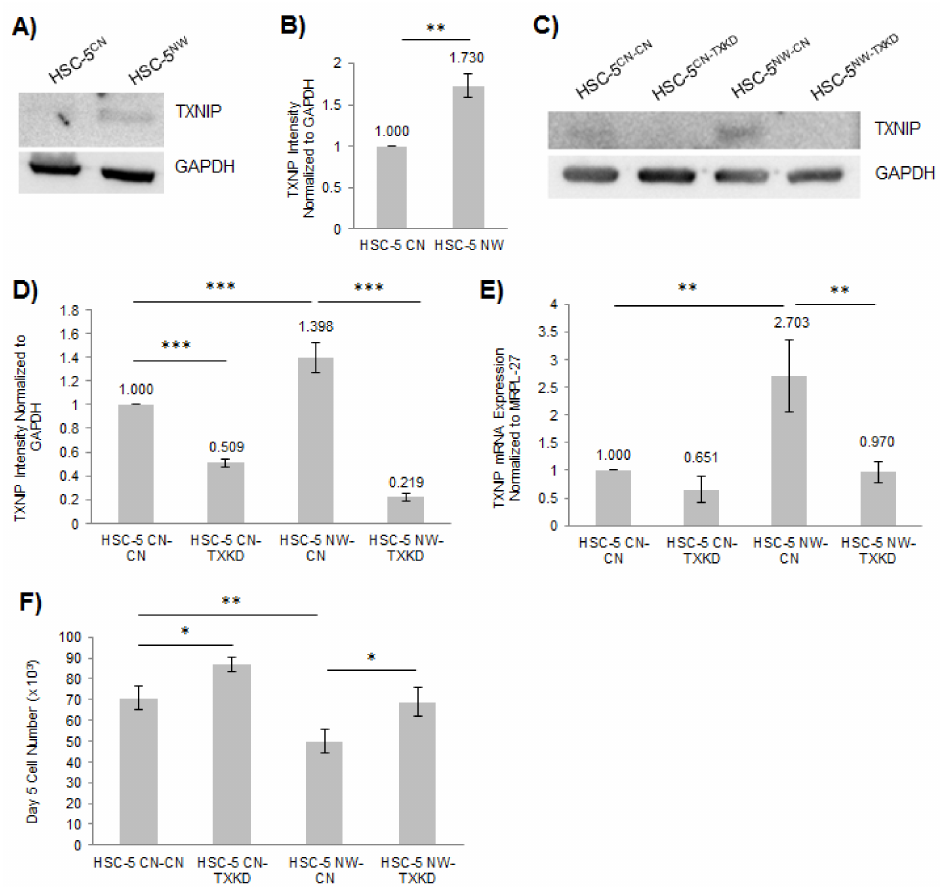
Figure 6. Knockdown of TXNIP expression in HSC-5 NW cells enhanced cell proliferation. ( A ) Representative Western blots of TXNIP and GAPDH in HSC-5 CN and HSC-5 NW cells; n = 3. ( B ) Densitometric quantification of the TXNIP/GAPDH ratio in HSC-5 CN and HSC-5 NW cells nor- malized to HSC-5 CN cells. ( C ) Representative Western blots of TXNIP and GAPDH in HSC-5 CN-CN , HSC-5 CN-TXKD , HSC-5 NW-CN and HSC-5 NW-TXKD cells; n = 3. ( D ) Densitometric quantification of the TXNIP/GAPDH ratio in HSC-5 CN-CN , HSC-5 CN-TXKD , HSC-5 NW-CN and HSC-5 NW-TXKD cells normalized to HSC-5 CN-CN cells. ( E ) Total RNA was extracted from HSC-5 CN-CN , HSC-5 CN-TXKD , HSC-5 NW-CN and HSC-5 NW-TXKD cells and reverse-transcribed to cDNA for quantifying TXNIP expression relative to MRPL-27 using real-time PCR, normalized to HSC-5 CN-CN cells. ( F ) The graph shows the total cell number after 5 days of incubation of HSC-5 CN-CN , HSC-5 CN-TXKD , HSC-5 NW-CN and HSC-5 NW-TXKD cells. All values are the mean ± SD, n = 3, * p < 0.05, ** p < 0.01, *** p <